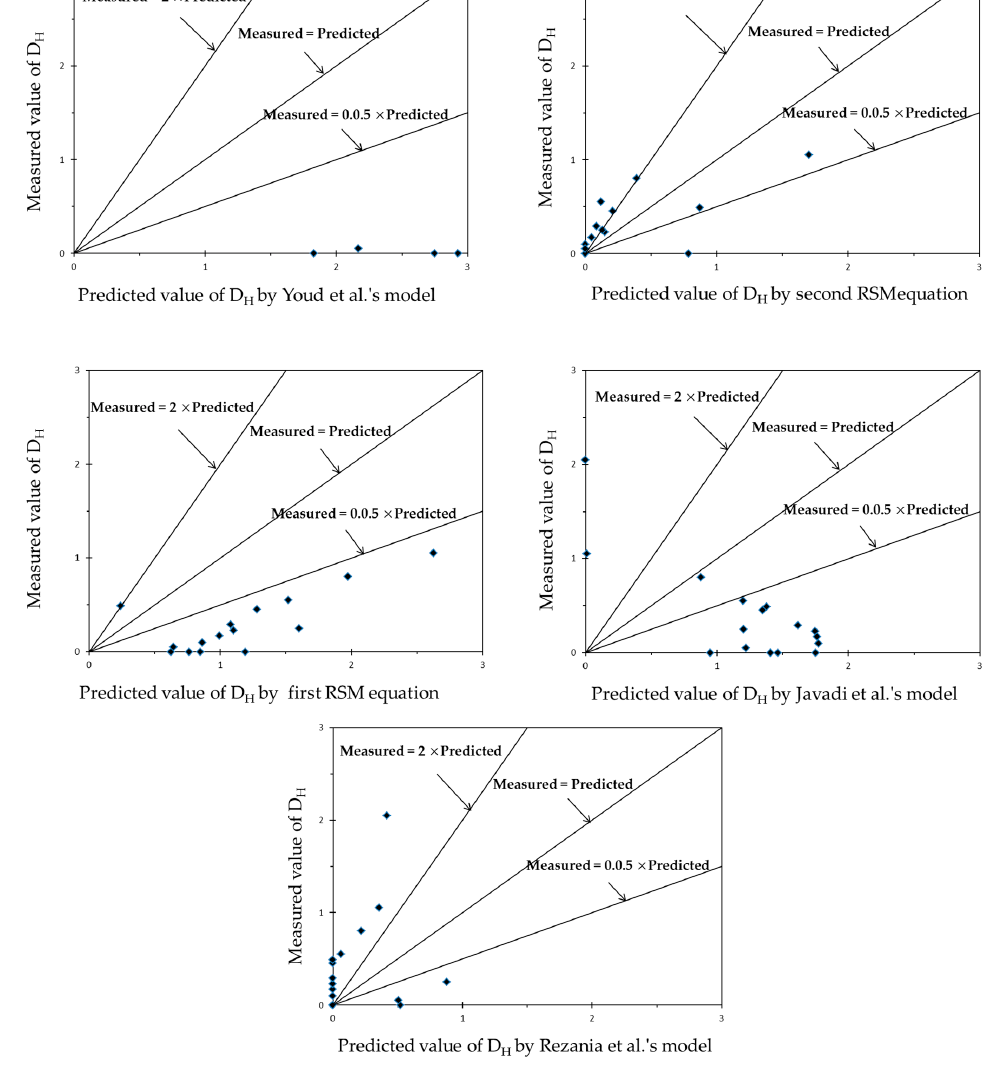
Figure 7. Comparison between both RSM equations and three extra models with 16 data points including F 15 of less than 28% measured from sites of the Chi-Chi earthquake.